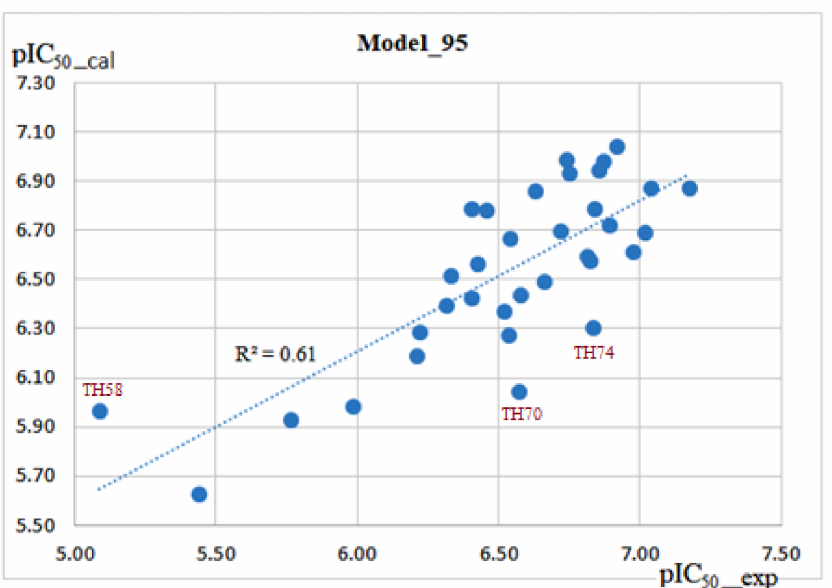
Figure 5. Correlation plot between the experimental pIC 50 values (X-axis) and the calculated pIC 50 values (Y-axis) for the training set molecules (blue points) using model